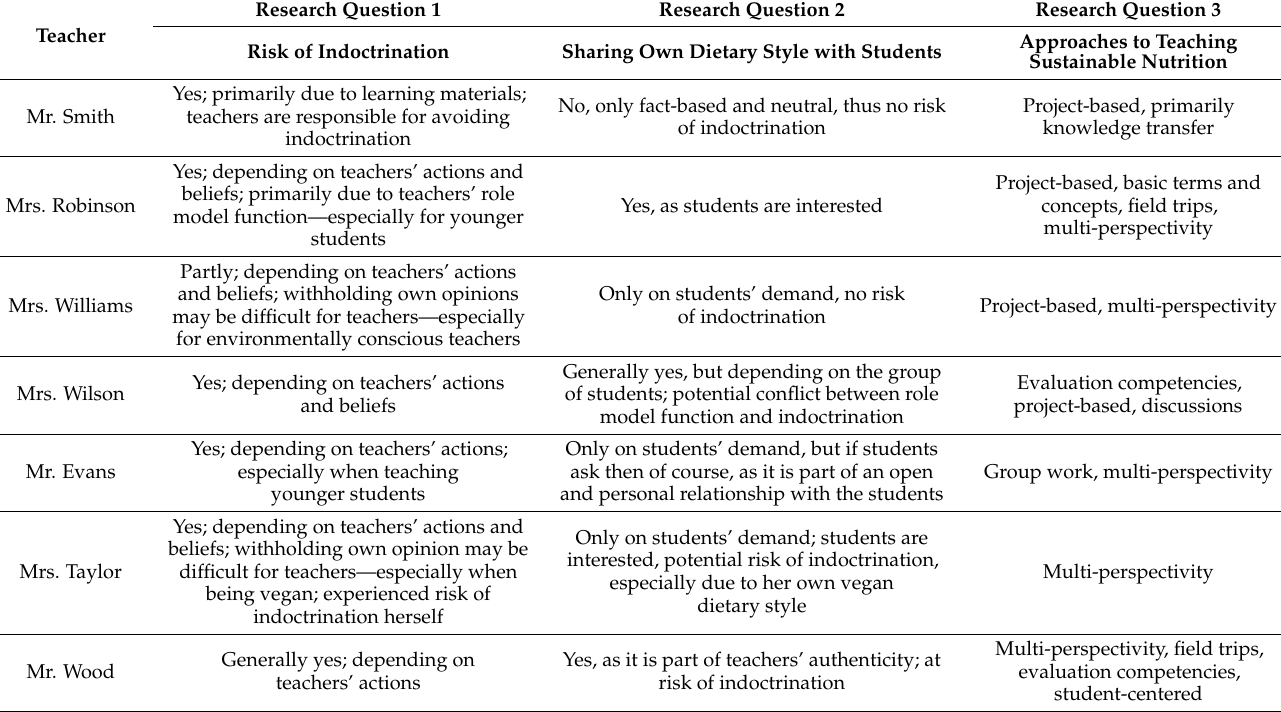
Table 2. Summary of the Main Findings Regarding the Three Research